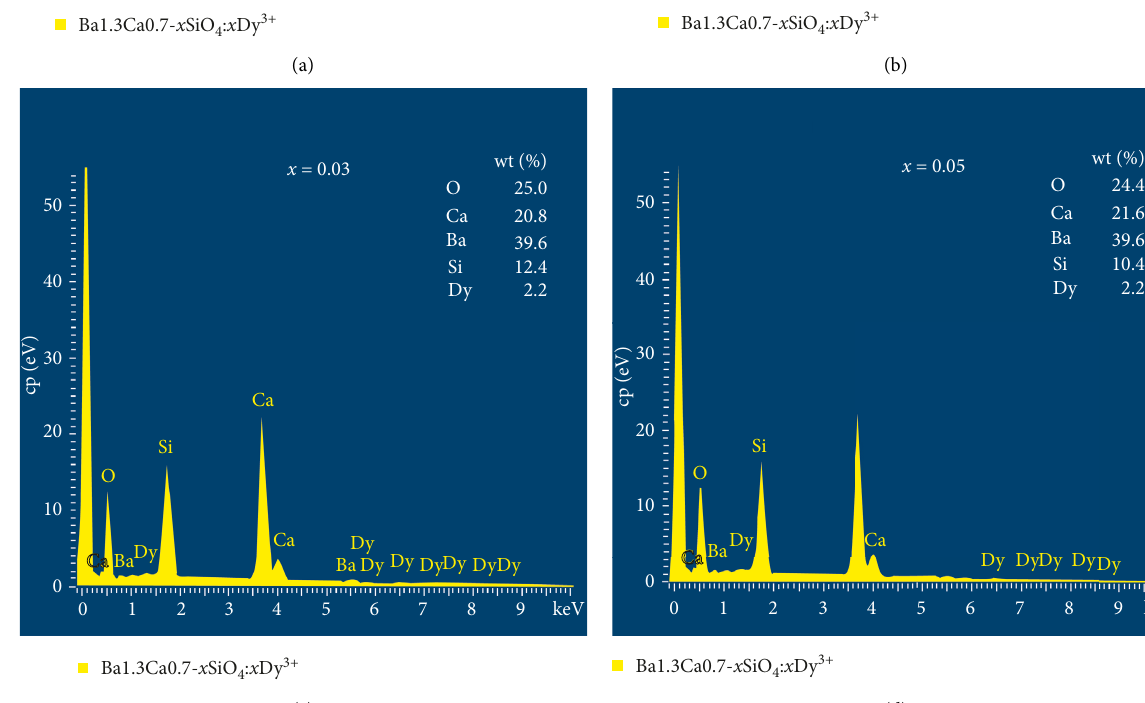
Figure 3: EDS spectra for Ba 3+ : (a) x � 0.00, (b) x � 0.01, (c) x � 0.03, and (d) x � 1.3 Ca 0.7 − x SiO 4 : x Dy